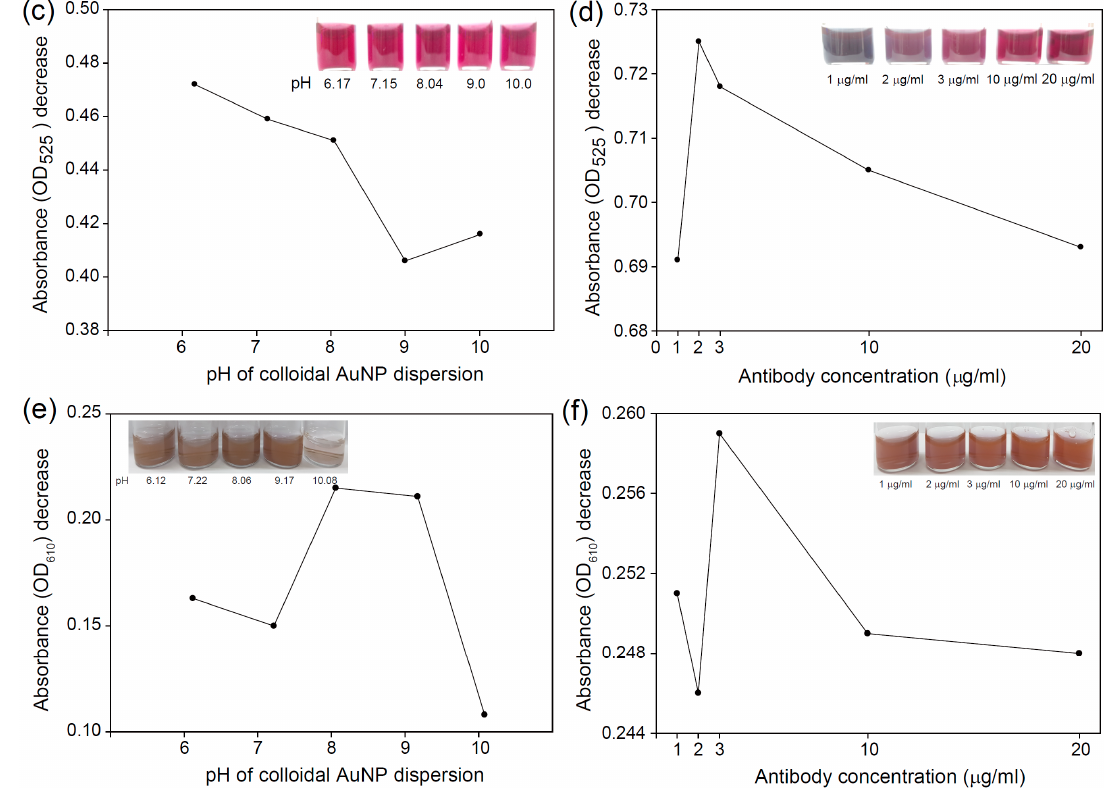
Figure 4. Changes in absorbance (OD 520, 525, and 610 ) of the AuNP dispersion after adding NaCl at various pH values and at various concentrations of antibody after adding NaCl for different-sized AuNPs: ( a , b ) for 34.0 ± 1.2 nm AuNP; ( c , d ) for 42.7 ± 0.8 nm AuNP; and ( e , f ) for 137.8 ± 0.45 nm AuNP. Insets are photographs of the AuNP dispersions.